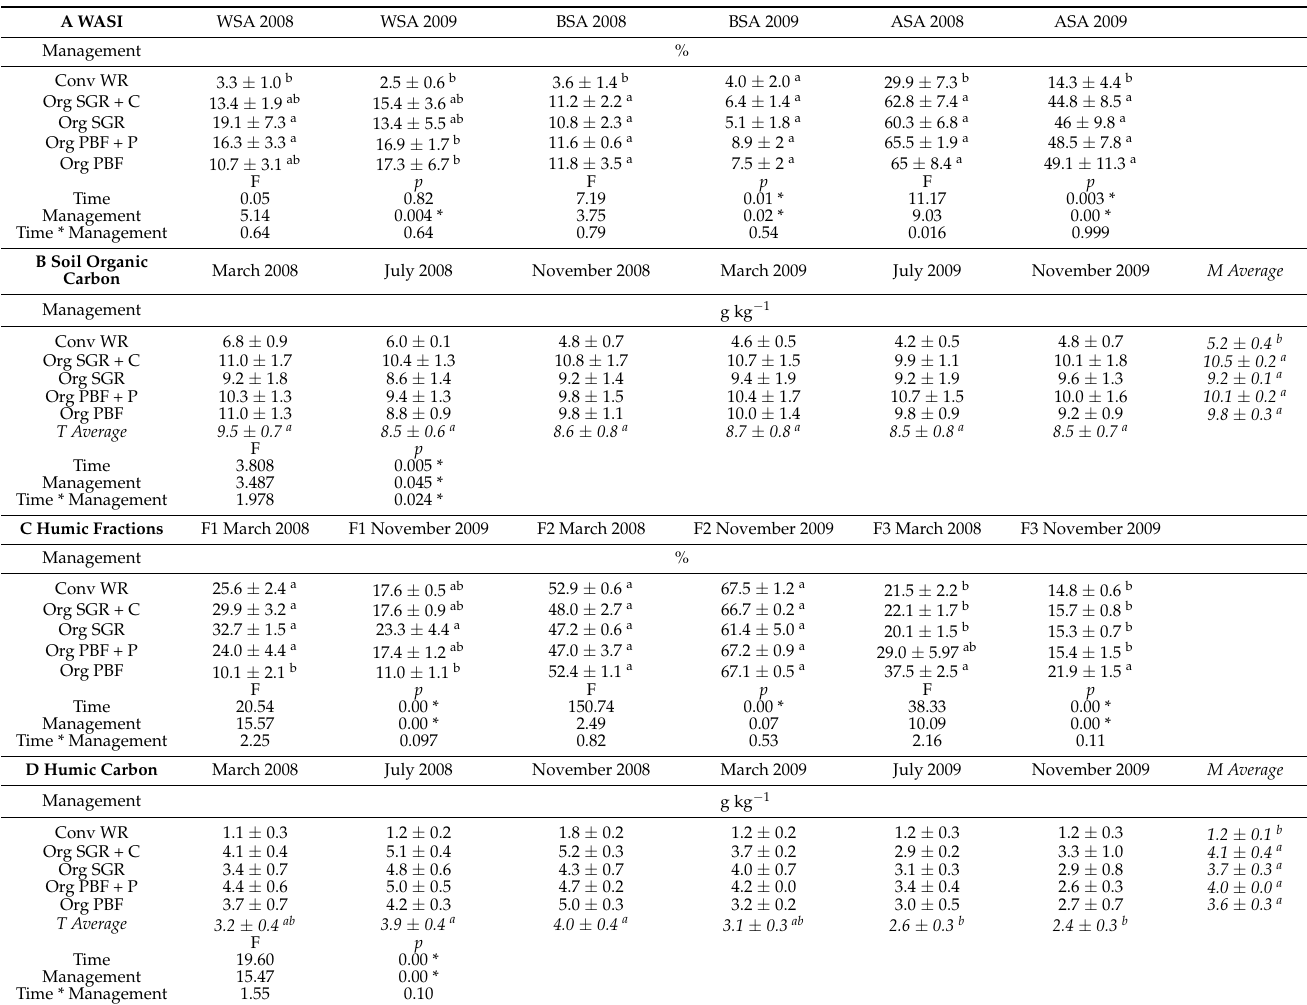
Table 5. Evolution of stability indexes (WASI), humic fractions, and humic carbon